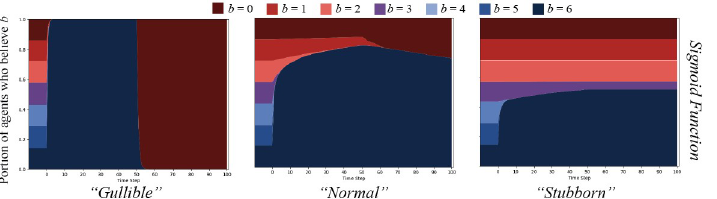
Fig 6. Sigmoid cognitive contagion function result comparisons. The split message set on an ER random graph, N = 250, ρ = 0.05, for agents updating their beliefs based on the sigmoid cognitive contagion function in Eq (6). Graphs display percent of agents who believe B with strength b over time. The left graph shows agents parameterized to be “gullible” ( α = 1, γ = 7), the middle shows “normal” agents ( α = 2, γ = 3), and the right, “stubborn” agents ( α = 4, γ =